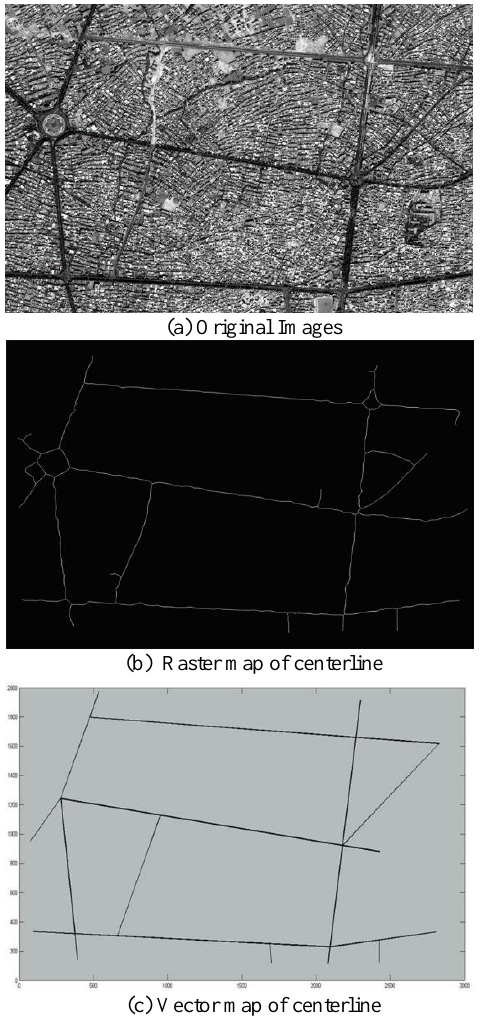
Figure 7. (Test Image II) Results of algorithm on various satellite images. 7(a) Original Images; 7(b) Raster map of centerline; 7(c) Vector map of centerline.